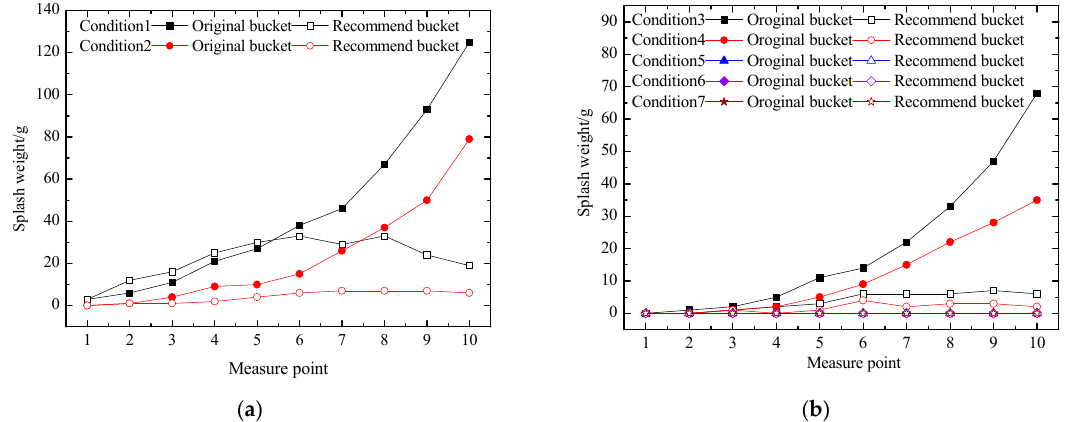
Figure 13. Splash weight at the bottom of the left slope of the physical model test: (a) represents the splash weight of condition 1 to condition 2; (b) represents the splash weight of condition 3 to condition 7.